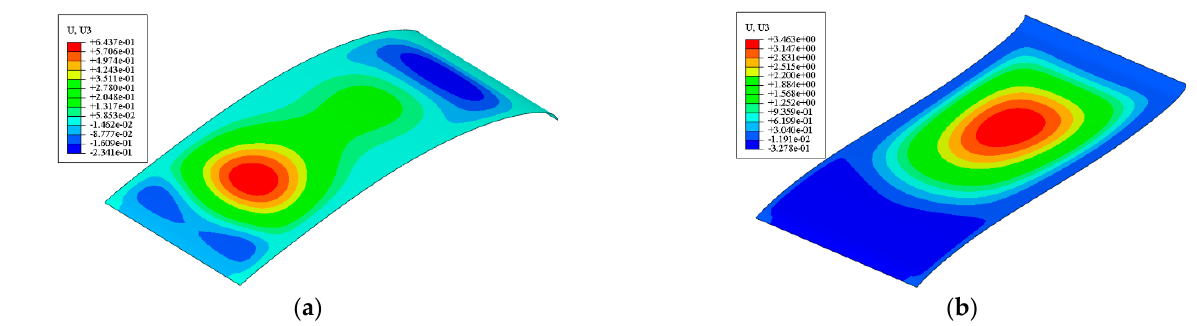
( c ) Figure 29. Aerodynamic performance of wing under different prestress: ( a ) v = 6.4 m/s; ( b ) v = 9.0 m/s; ( c ) v = 11.0 m/s. The above research provides a scientific basis for the laying of membrane skin of long-endurance low-speed UAV. Firstly, the spanwise prestress can be increased as much as possible if the structure permits, so that the aerodynamic characteristics are closer to the numerical results based on the assumption of rigid body. Secondly, the chordal prestress can be properly applied on the upper surface according to the wing load, which is helpful to eliminate the deformation caused by aerodynamic force. However, if the prestress is too large, it will also lead to the concave of convex surface and the damage of the section shape. Finally, the chordal prestress should not be applied to the lower surface. Under any working condition, the chord prestress will increase the concave amount in the front of the lower surface and the aerodynamic parameters deviate from the design result. 5.3. Material As mentioned in Chapter 2, the solar aircraft carries two types of membrane skins, which have different characteristics. However, because the laying of photovoltaic skin is difficult to reach the ideal conditions, it is difficult to study the influence of deformation on its aerodynamic performance through experiments. In this section, the deformation laws and aerodynamic characteristics of the two wings under ideal conditions are compared through a numerical method. The comparison of upper surface deformation is shown in Figures 27a and 30a. The photovoltaic skin wing shows a similar deformation trend to the polyimide skin wing, while the maximum deformation of photovoltaic skin wing is smaller. As shown in